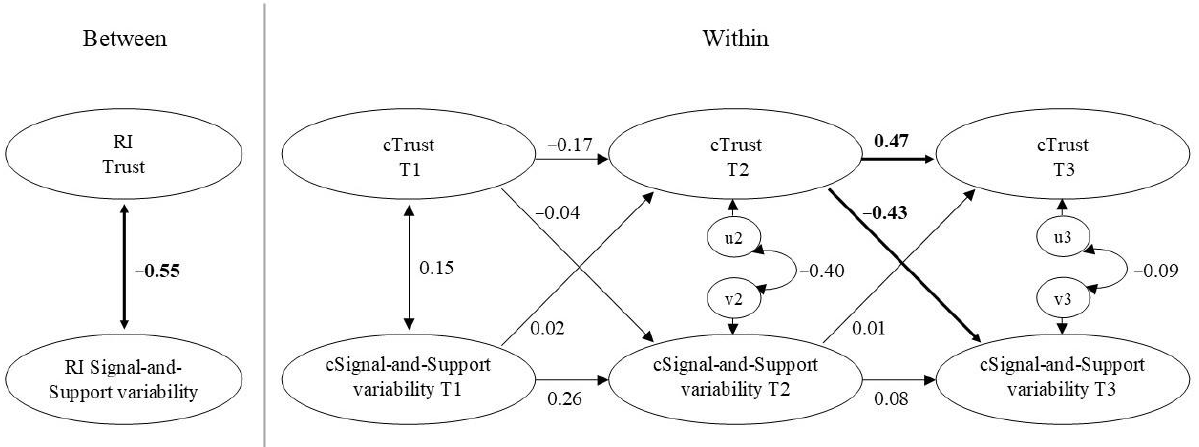
Figure 2. Simplified presentation of the RI-CLPM model between trait Trust and Signal-and-Support variability. The between-level is presented on the left, and the within-level is presented on the right. Standardized estimates are presented. Significant effects are in boldface. RI = Random intercept; c = within-person centered.